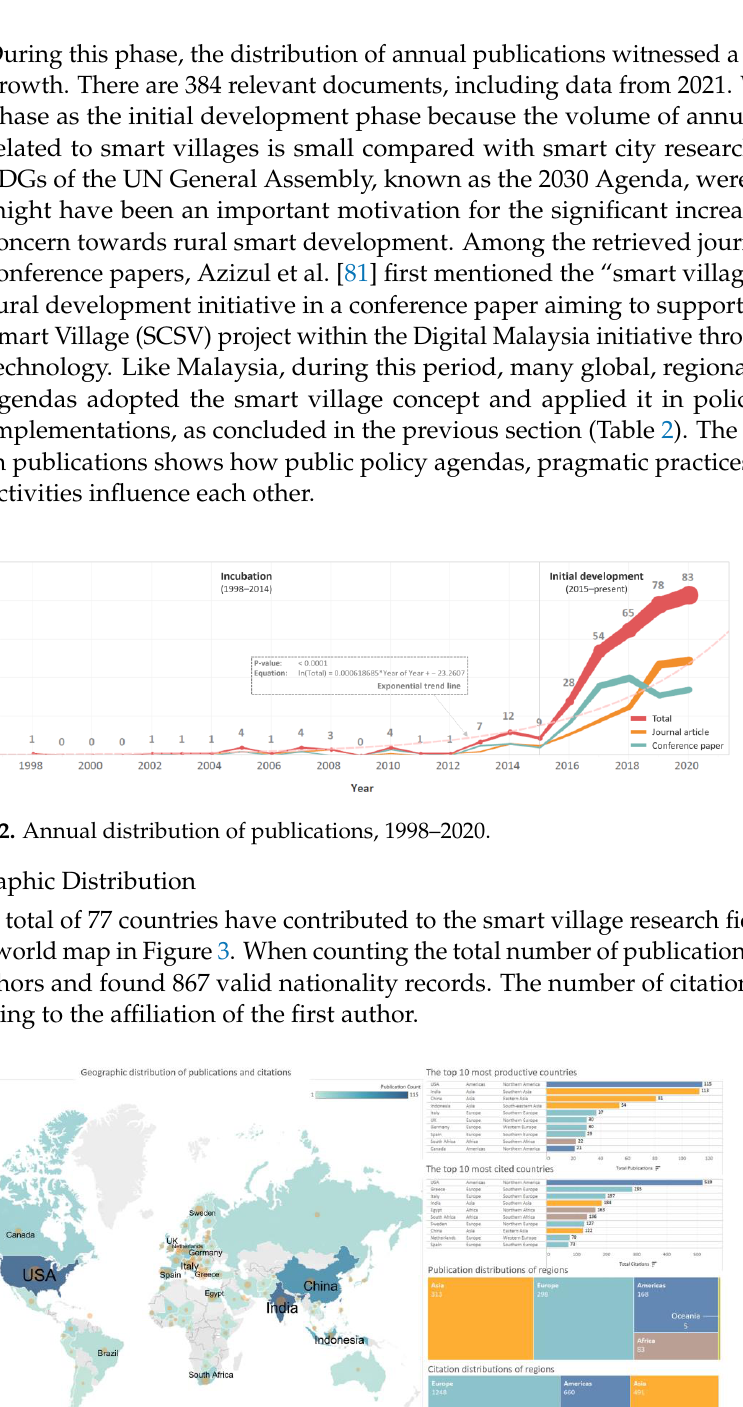
Table 4. Top 15 most relevant authors.